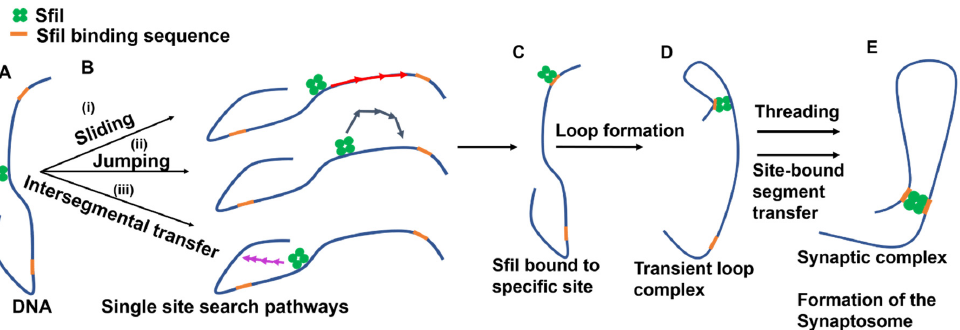
Figure 7. Model for the formation of the synaptosomes by SfiI. ( A ) Initial binding of SfiI (green) to the DNA with two SfiI recognition sites (orange). ( B ) Different site-search pathways. (i) sliding, (ii) jumping, and (iii) intersegmental transfer utilized by the proteins in search fora single specific site. ( C ) SfiI bound to specific site on the DNA. ( D ) Formation of transient loop complexes due to site-bound transfer or DNA diffusion. ( E ) Formation of the synaptic complex after utilizing the threading and or site-bound segment transfer